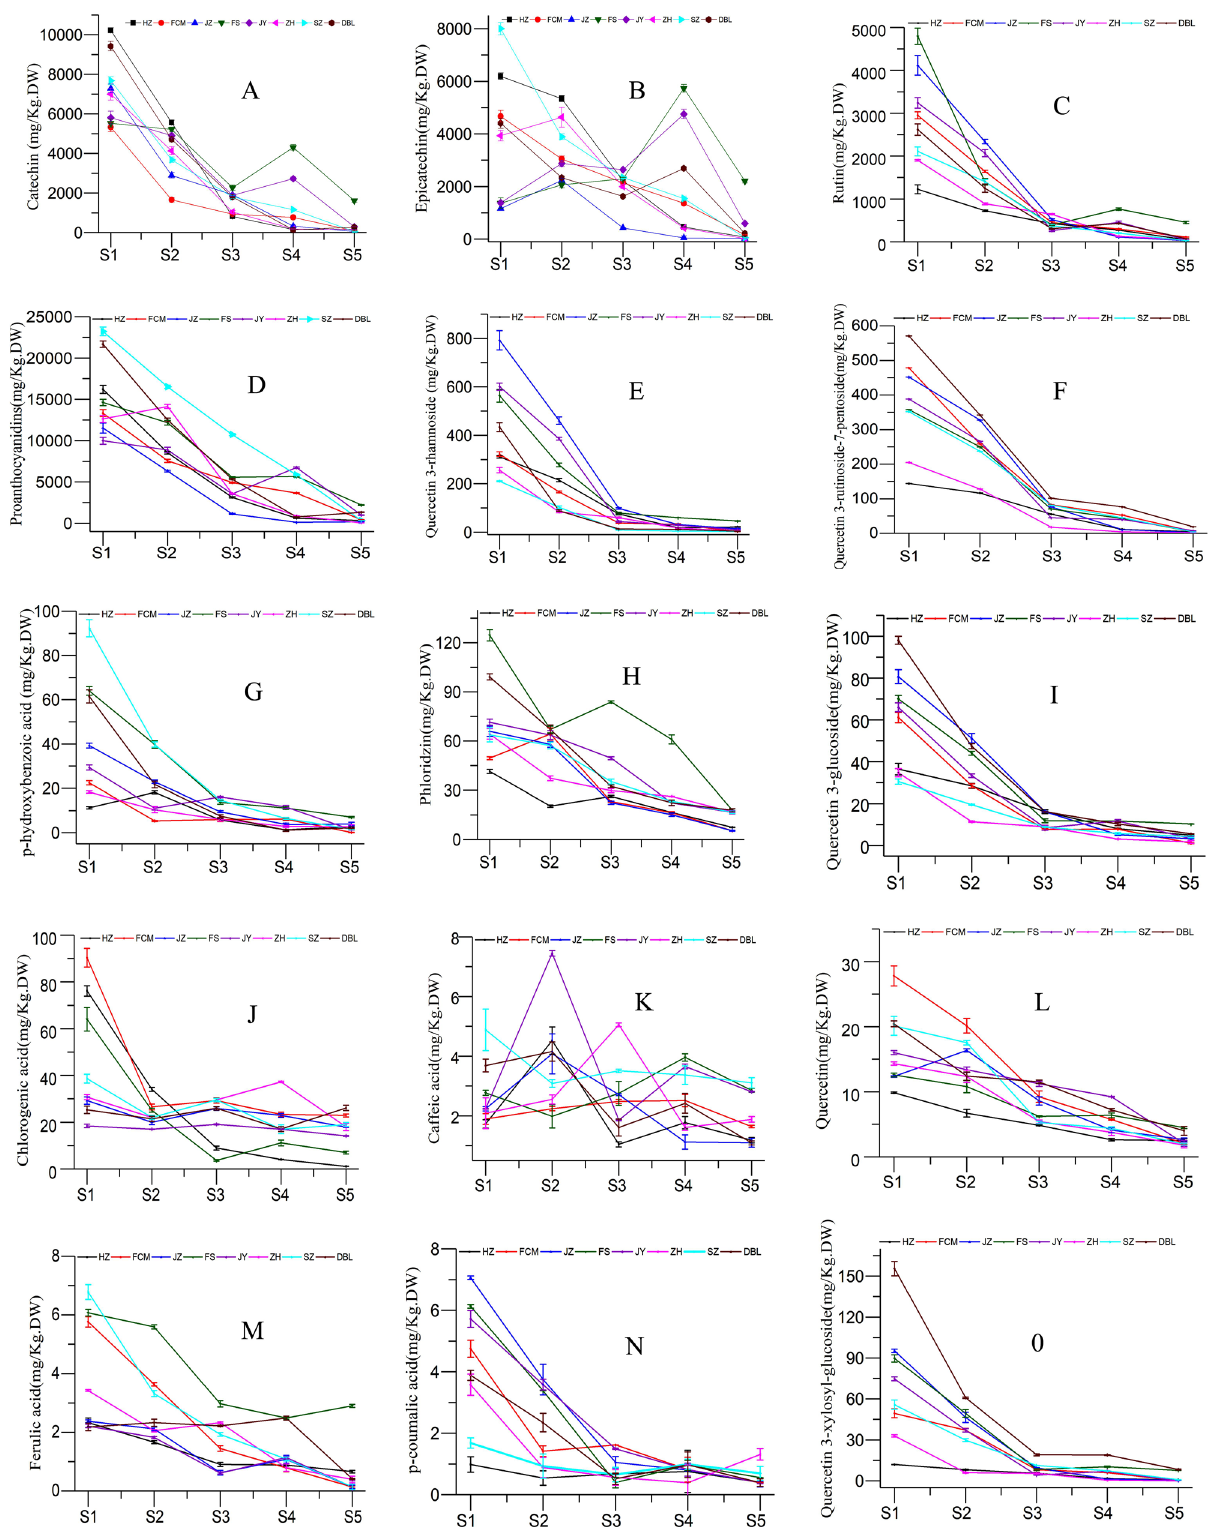
Figure 9. Change in the phenolic profile of jujube fruit in various developmental